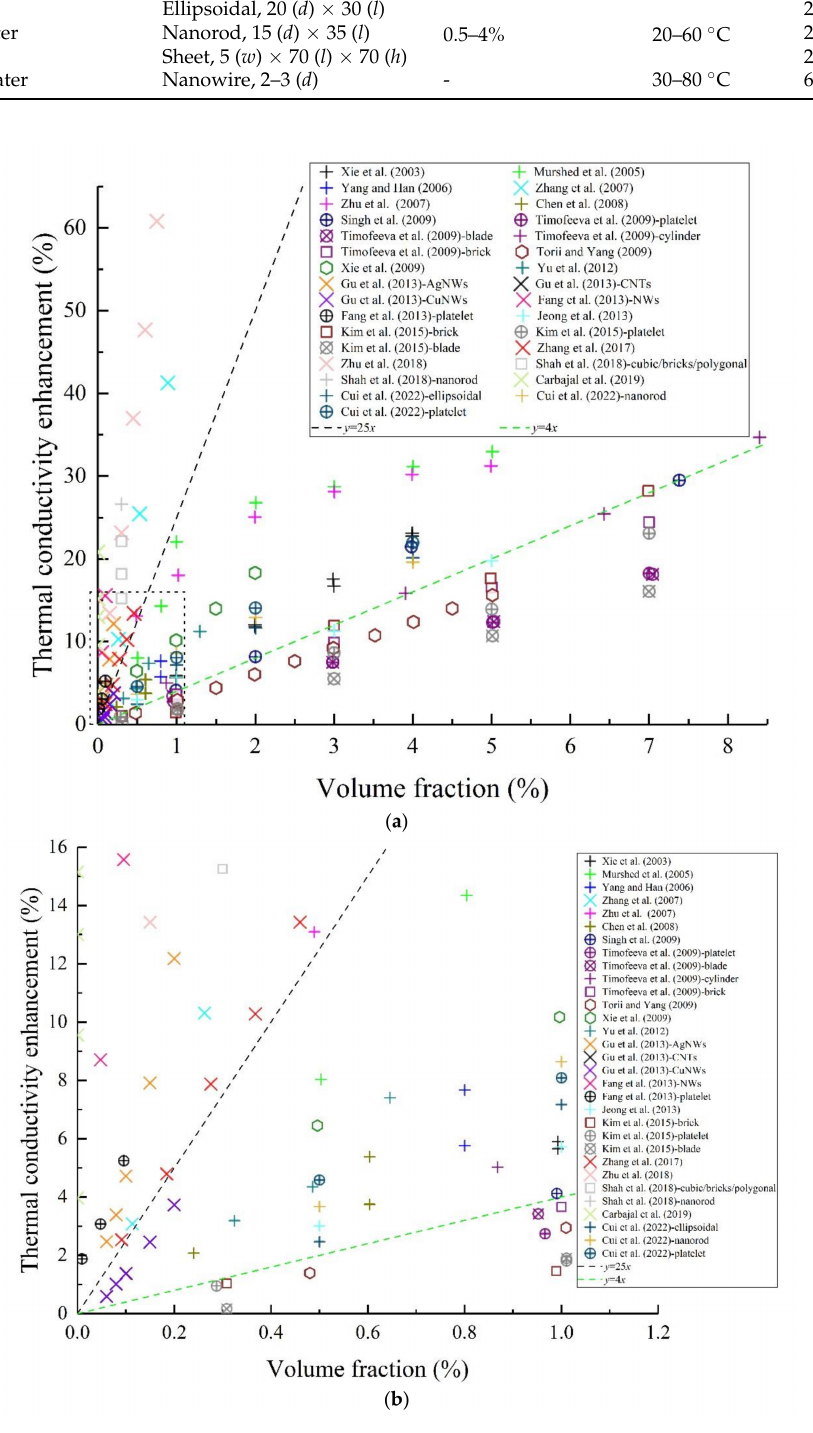
Figure 2. Collection of experimental data for TCE of NSN nanofluids at room temperature ( × : CNTs/nanofibers/nanowires; +: nanorods/cylinders/ellipsoids; : platelets; : blades; (cid:3) : bricks; : diamonds). ( a ) Full range. ( b ) Enlarged low-volume-fraction region (volume frac- tion < 1.2%, TCE < 16%)